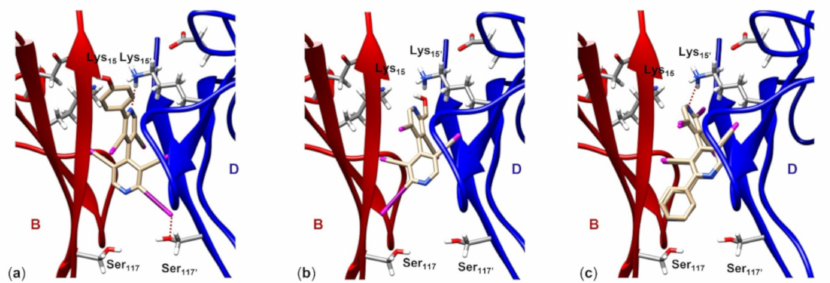
Figure 7. Docking modes into the T 4 binding pocket (BD) for the ( M )-enantiomers of 9 ( a ), 10 ( b ) and the pair 7 / 8 (superimposed structures) ( c